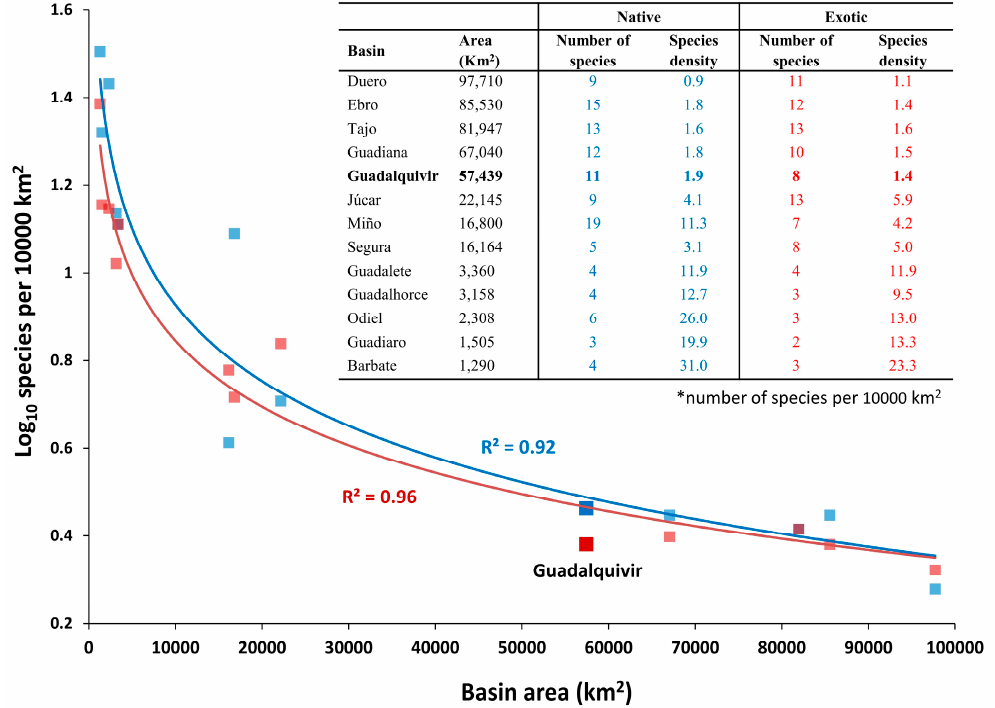
Figure 5. Species density–basin area relationship for the main Iberian basins. Drainage area, freshwater fish number and species density are shown. Raw data from: [28,68,69]. The blue color refers to the native species and the red to the exotic ones.